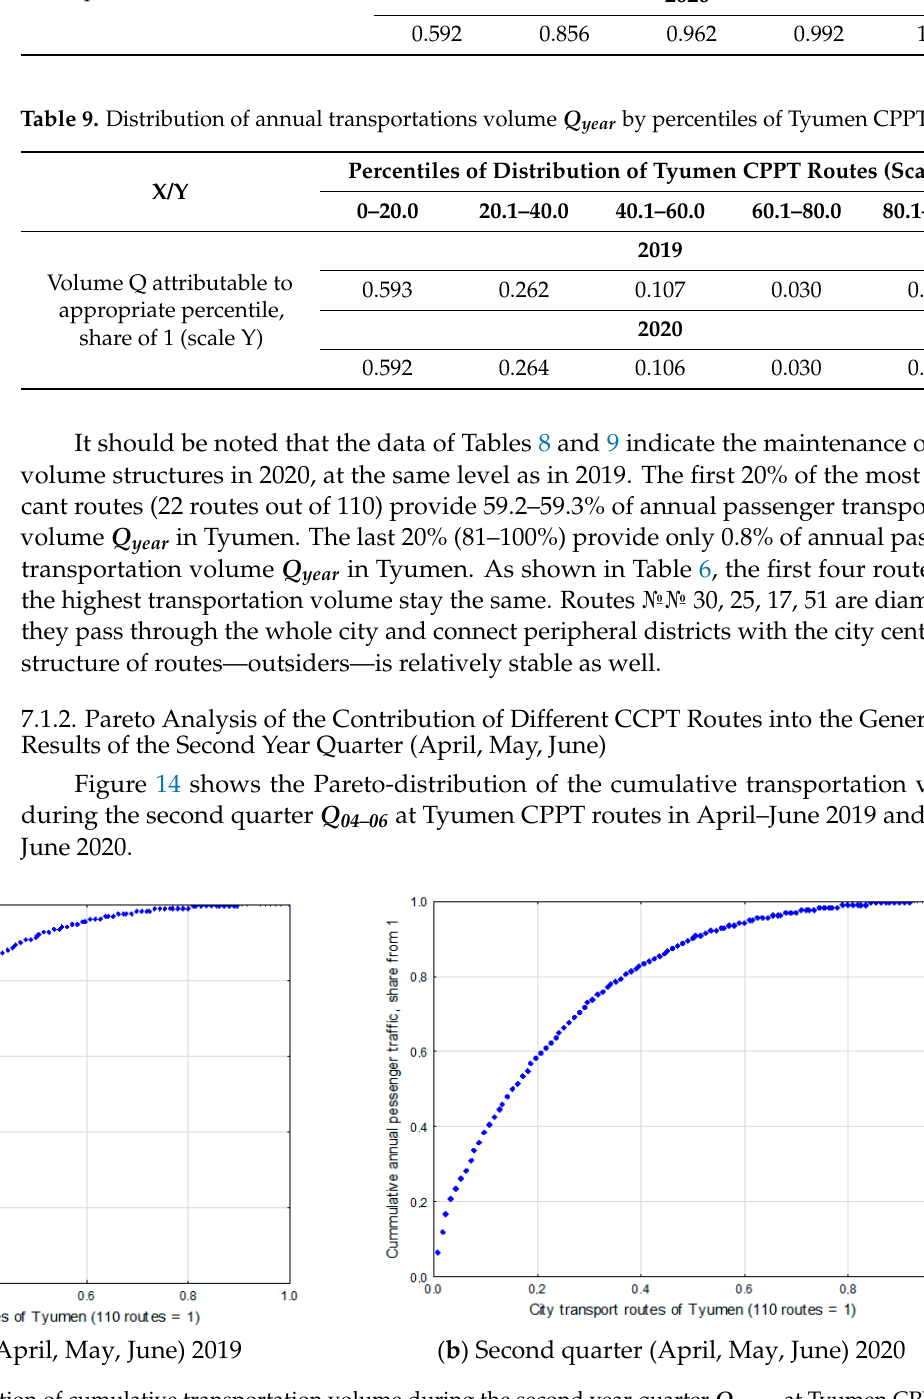
Figure 14. Pareto-distribution of cumulative transportation volume during the second year quarter Q 04–06 at Tyumen CPPT routes. Note: scales of coordinate planes are normalized in range [0, 1].